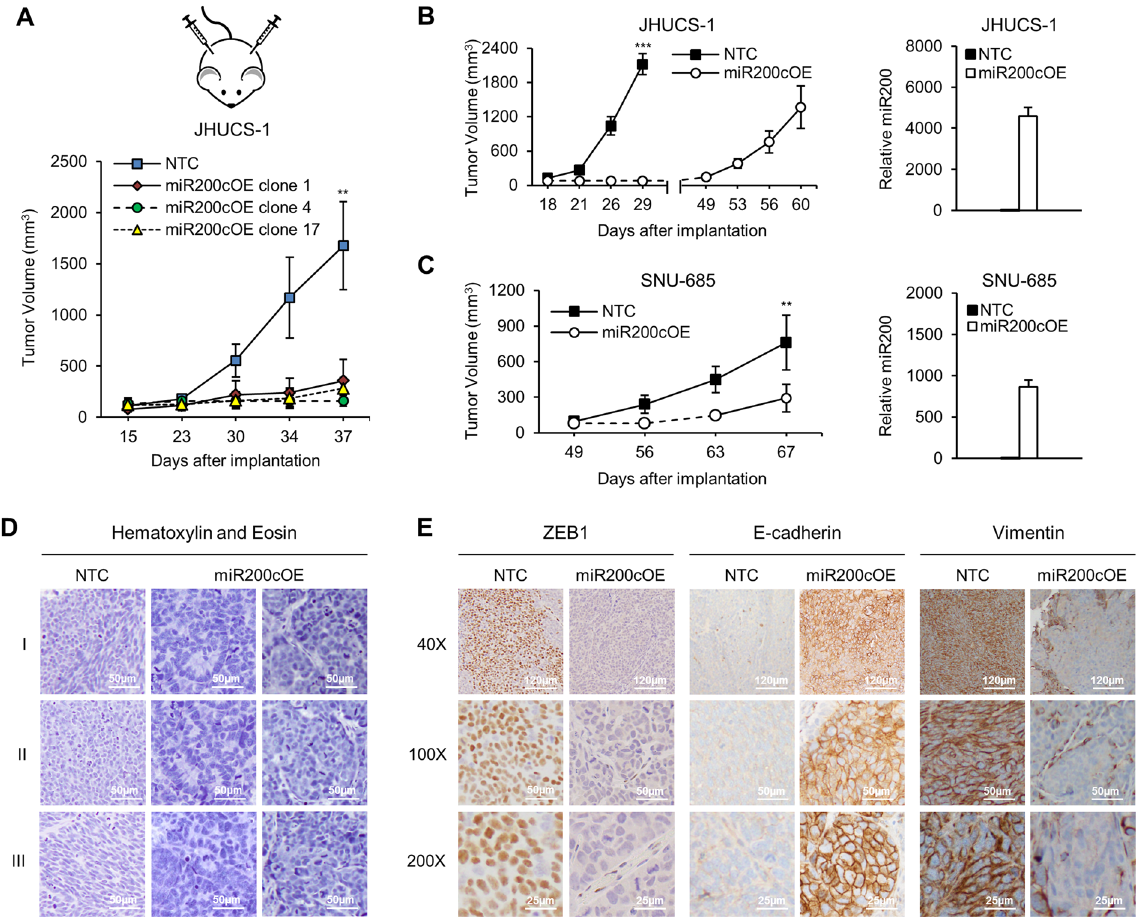
Figure 5. miR-200 overexpression in UCS xenograft tumor models. NSG mice were subcutaneously injected with miR-200c-overexpressed and control cells. ( A ) Tumor growth in control vs. 3 different miR-200c- overexpressed JHUCS-1 clones over 37 days (n = 4 per group). ( B ) JHUCS-1 and ( C ) SNU-685 tumor growth in mice bearing miR-200c-overexpressed vs. control cells over 60 and 67 days, respectively (n = 5 per group). Bar graphs depict relative miR-200c expression in xenografted tumors. All graphical data are reported as mean ± SD. ** P ≤ 0.01, *** P ≤ 0.001; Student’s T-test for independent samples. ( D ) H&E staining of JHUCS-1 xenografted tumors. All images were taken at 100X magnification. Scale bar, 50 µ m. Rows I, II and III represent different sections of tumor. All NTC were comprised of predominantly spindled cells. ( E ) IHC for ZEB1 (nuclear), E-cadherin (membranous) and vimentin (cytoplasmic). For tumors with complete loss of protein expression, staining of blood vessels and stromal cells served as internal positive controls. Rows represent increasing magnification from top to